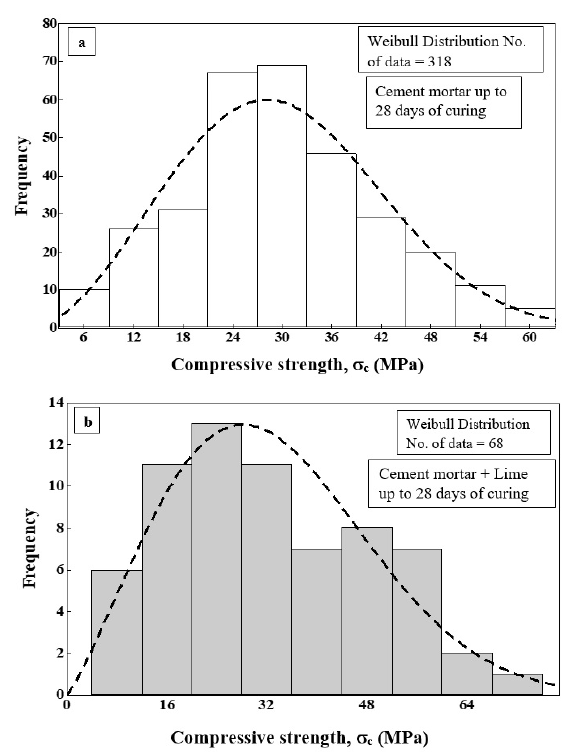
Figure 5: Histogram of percent of lime used in the literature